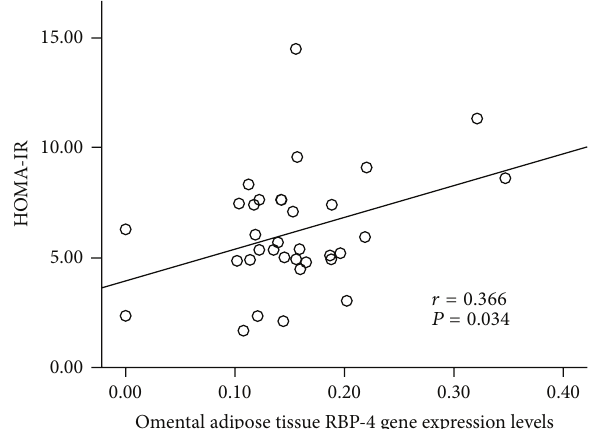
Figure 2: Correlation between tissue RBP-4 gene or protein expres- sion and blood insulin resistance